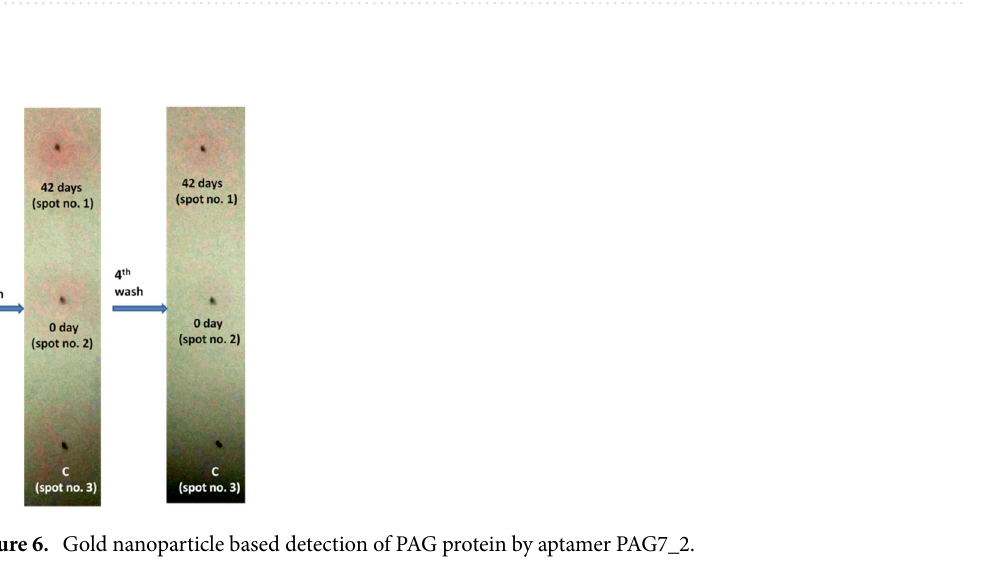
Figure 5. The 3 D structure of PAG 7 and 18 proteins. Highlighted regions represent peptide sequence against which aptamers were selected.